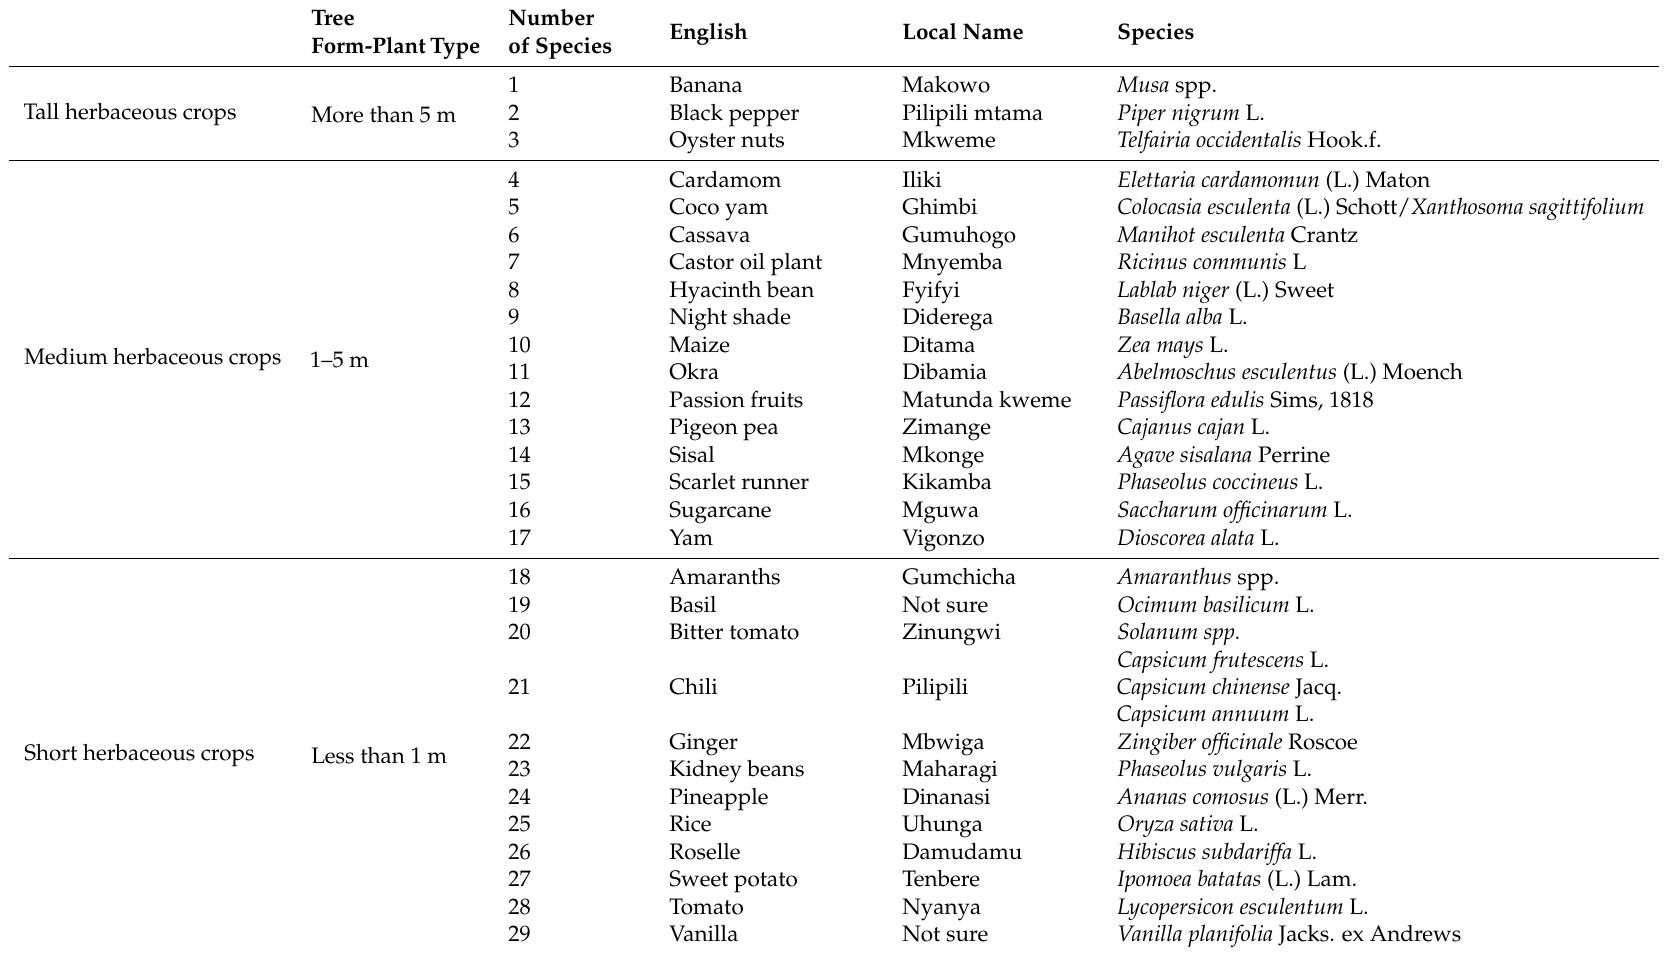
Table 3. Classification of the 24 herbaceous crops observed in the homegardens of the 43 households according to their